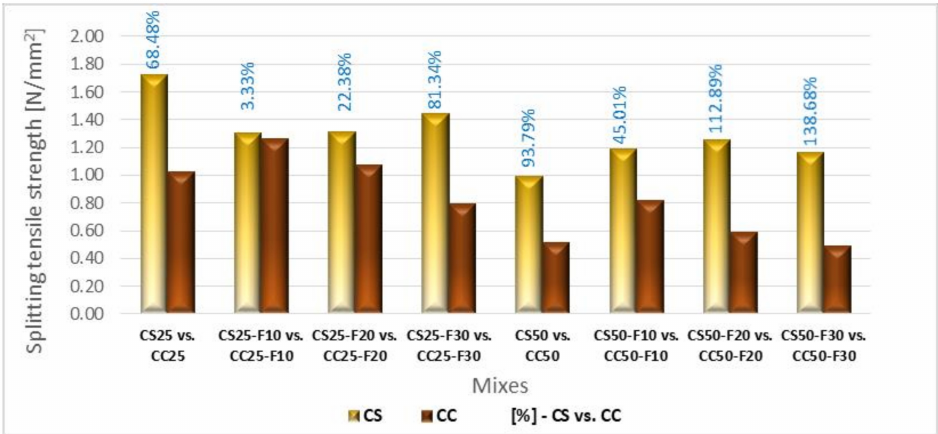
Figure 20. Splitting tensile strength variation of the composites with sunflower aggregates versus composites with corn cob aggregates